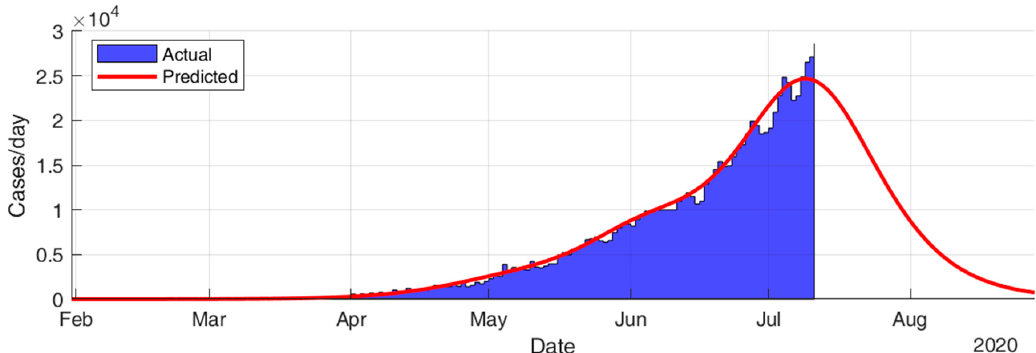
Figure 20. Prediction results for infection cases in India.